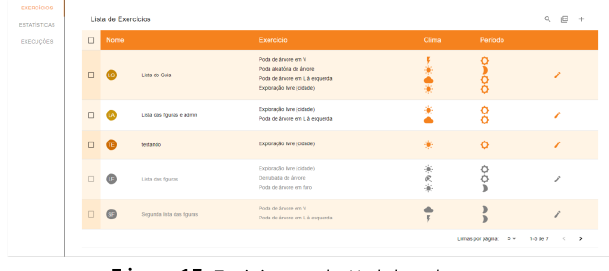
Figure 17. Trainings on the Web-based system.